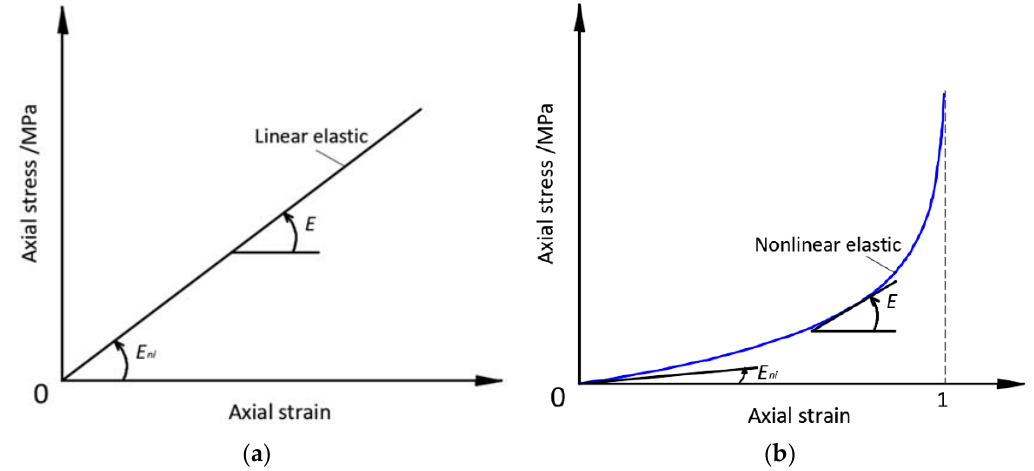
Figure 3. Linear and nonlinear elastic curves ( a ‐ Linear elastic; b ‐ Nonlinear elastic).